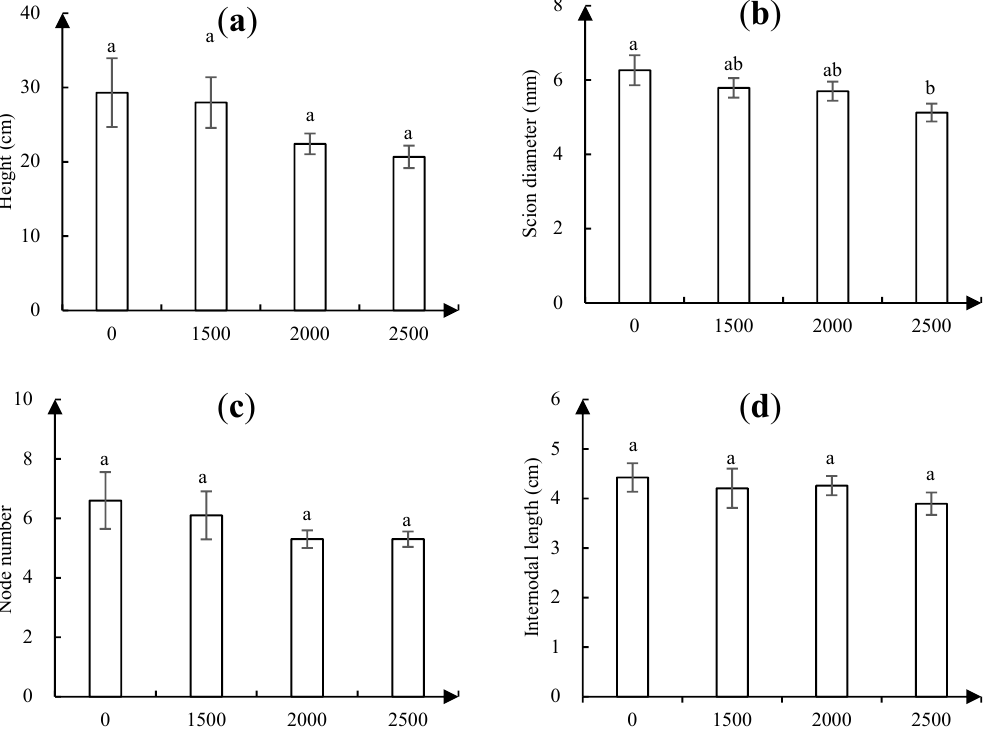
Figure 4. The effects of different concentrations of uniconazole on height ( a ), internodal length ( b ), scion diameter ( c ), and node number ( d ) in M. wufengensis . Different small letters indicate significant differences among treatments as assessed by the Duncan’s test ( p < 0.05). Bars represent means ± SDs ( n = 3). The same is shown below.